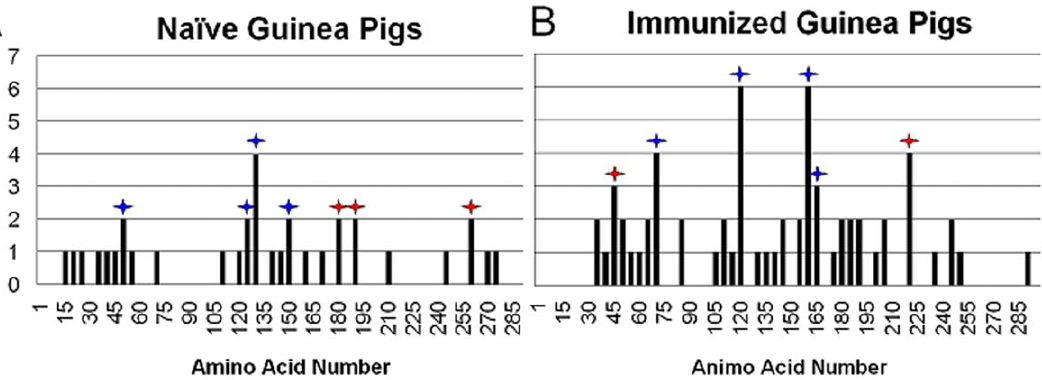
Figure 2. Histogram of influenza mutations by HA amino acid residue. Bars show the number of mutations at each amino acid observed in variants isolated from nasal washes of influenza virus infected Guinea pigs by sets of five residues as numbered. Panel A: variants from naı¨ve Guinea pigs, Panel B: variants from HA-immunized animals. Blue stars above bars indicate mutations that occurred within known epitopes. Red stars above bars indicate mutations that occurred outside known epitopes. doi:10.1371/journal.pone.0020130.g002 PLoS ONE |